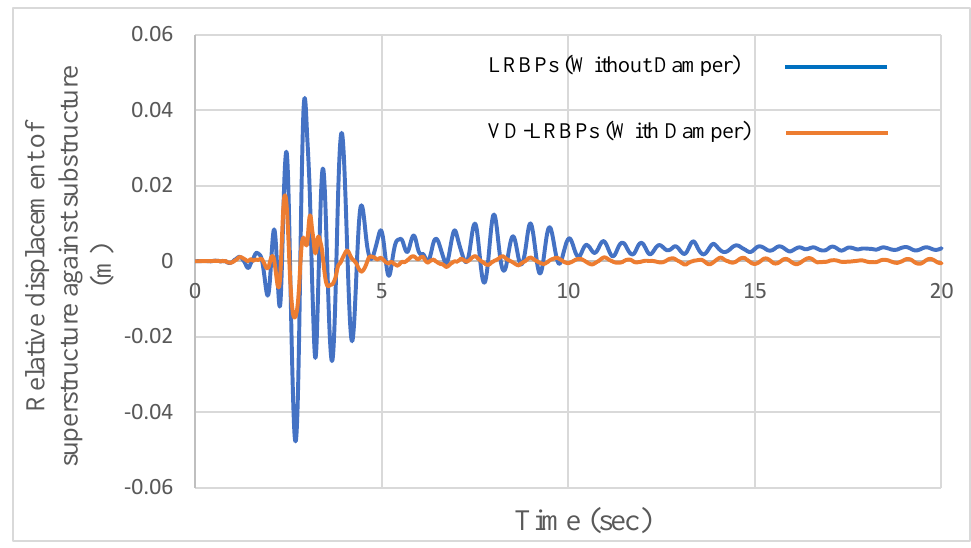
Figure 22. The relative displacement of superstructure against substructure histories under Kobe (Japan) earthquake.